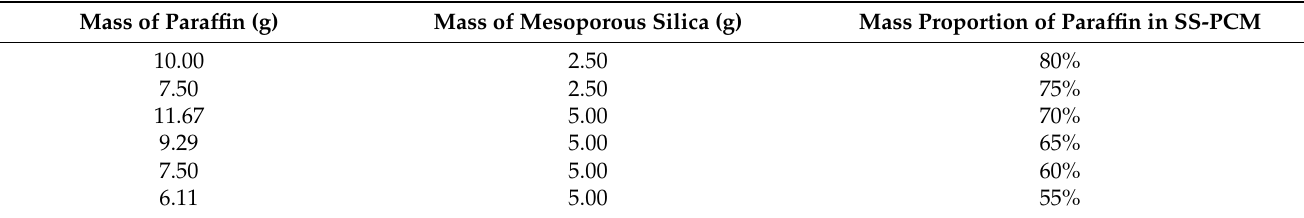
Table 1. The mass ratios of paraffin and mesoporous silica in SS-PCMs. Mass of Paraffin (g) Mass of Mesoporous Silica